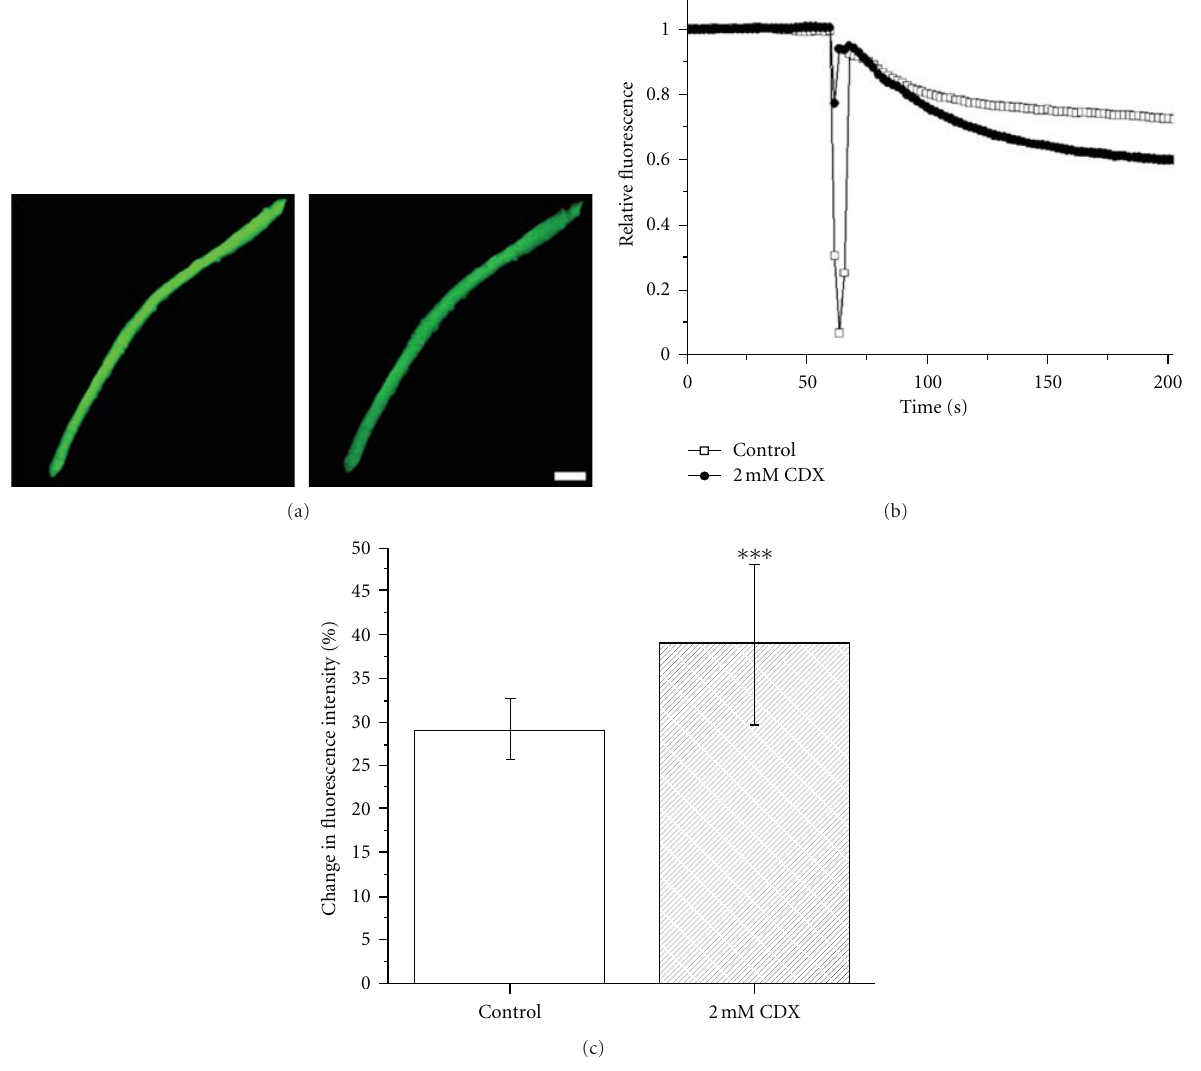
Figure 5: Cholesterol depletion increases the water permeability of isolated myofibers. (a) Fluorescence micrographs of a calcein-loaded myofiber before (left) and 140 s after switching to the hypotonic bu ff er (right) that indicates decreased fluorescence. The myofiber was not treated with CDX. Scale bar, 50 μ m. (b) Examples of the relative fluorescence (fluorescence at certain time point divided by the fluorescence at the beginning of the experiment) recordings for myofibers treated or not treated with CDX are shown. A sharp decline of the fluorescence intensity was often seen upon switching to the hypotonic bu ff er, owing to sample movement. (c) The change of fluorescence intensity is presented as a percentage between the value of fluorescence intensity in isotonic bu ff er just before and 140 s after switching from isotonic to hypotonic condition. N = 14 (control) and 16 (CDX-treated) myofibers from five di ff erent isolations. ∗∗∗ P < 0 .